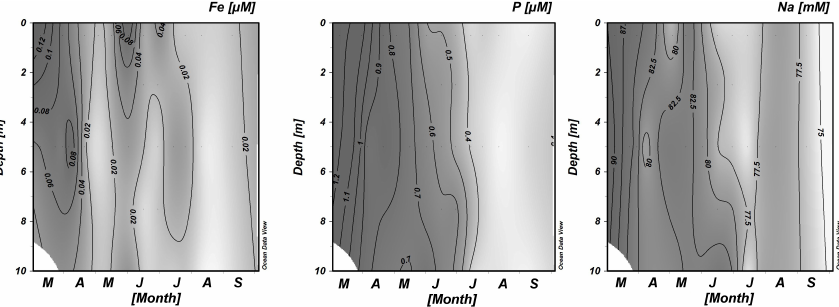
Fig. 9. Variations of total Fe (unfiltered samples), phosphorus (P) and sodium (Na) for the uppermost 10m at the Landsort Deep station. This figure was prepared with Ocean Data View using DIVA gridding. for samples taken at 0.5, 5 and 10m